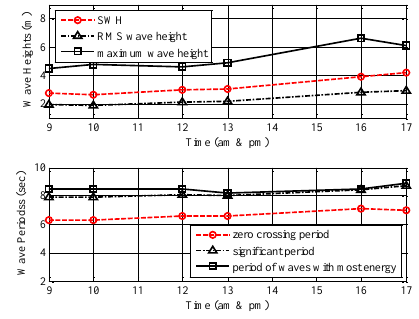
Figure 9. Wave heights and periods during the day when the experiments were conducted.